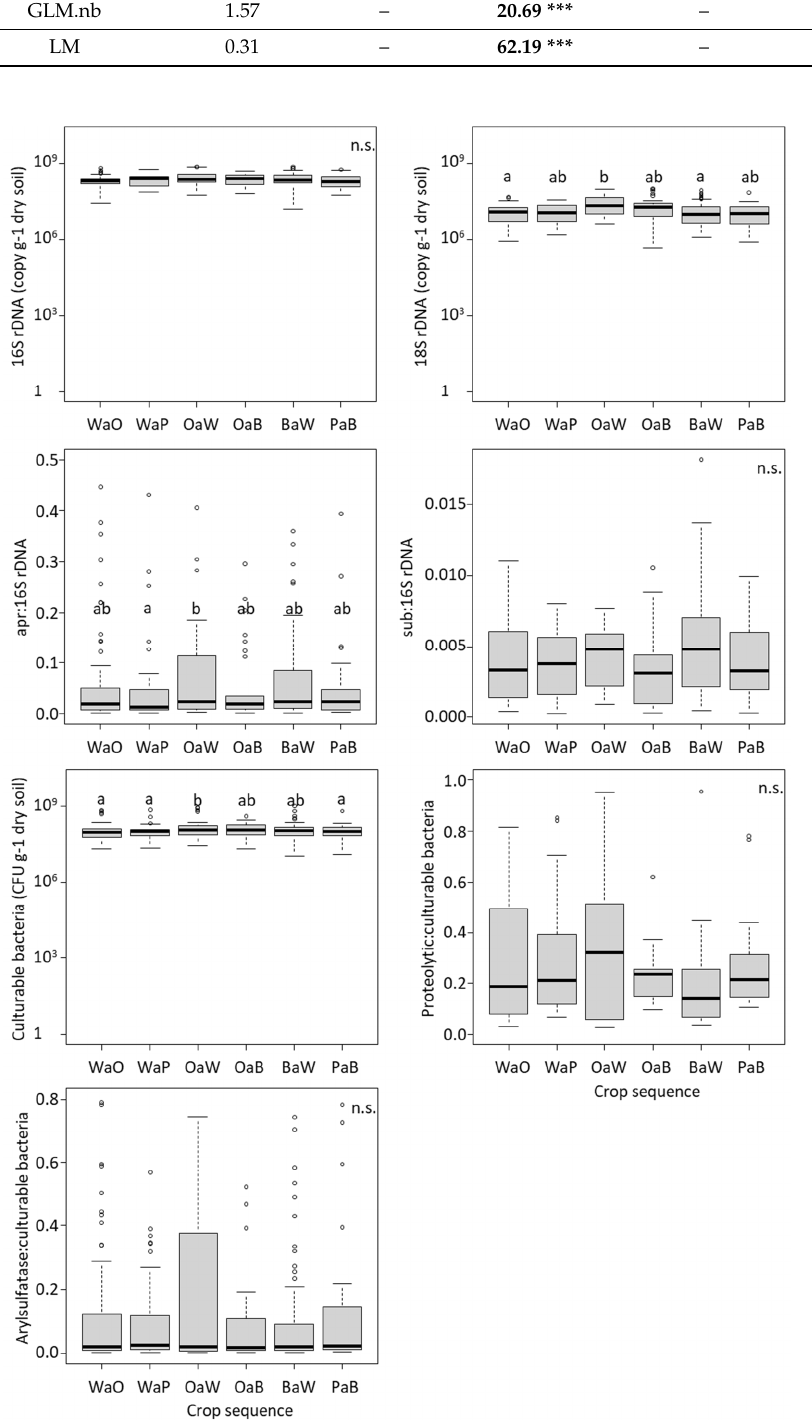
Figure 1. Microbial groups abundances in soil under different crop sequences. Boxplots with different letters indicate significant differences between species ( p < 0.05, n.s.—not significant, Tukey post-hoc test). WaO, wheat after oilseed rape; WaP, wheat after pea; OaW, oilseed rape after wheat; OaB, oilseed rape after barley; BaW, barley after wheat; PaB, pea after